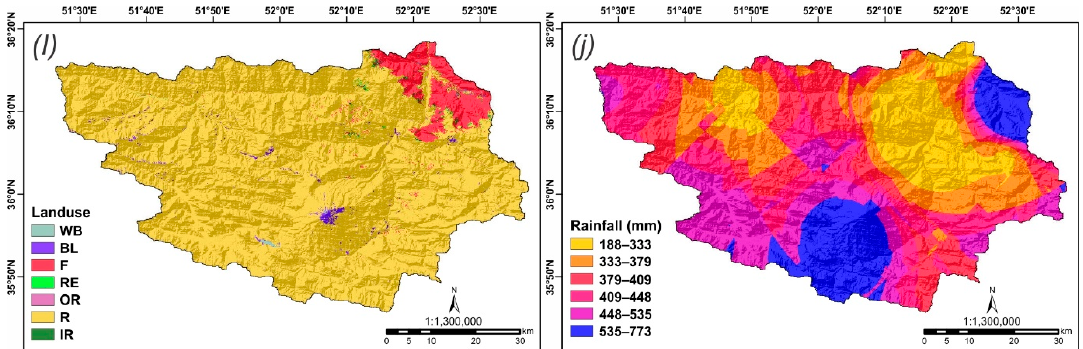
Figure 3. Flood conditioning factor maps in the study area: slope degree ( a ), altitude ( b ), curvature ( c ), SPI ( d ), TWI ( e ), river density ( f ), distance to river ( g ), lithology ( h ), land-use ( i ), and rainfall ( j ).